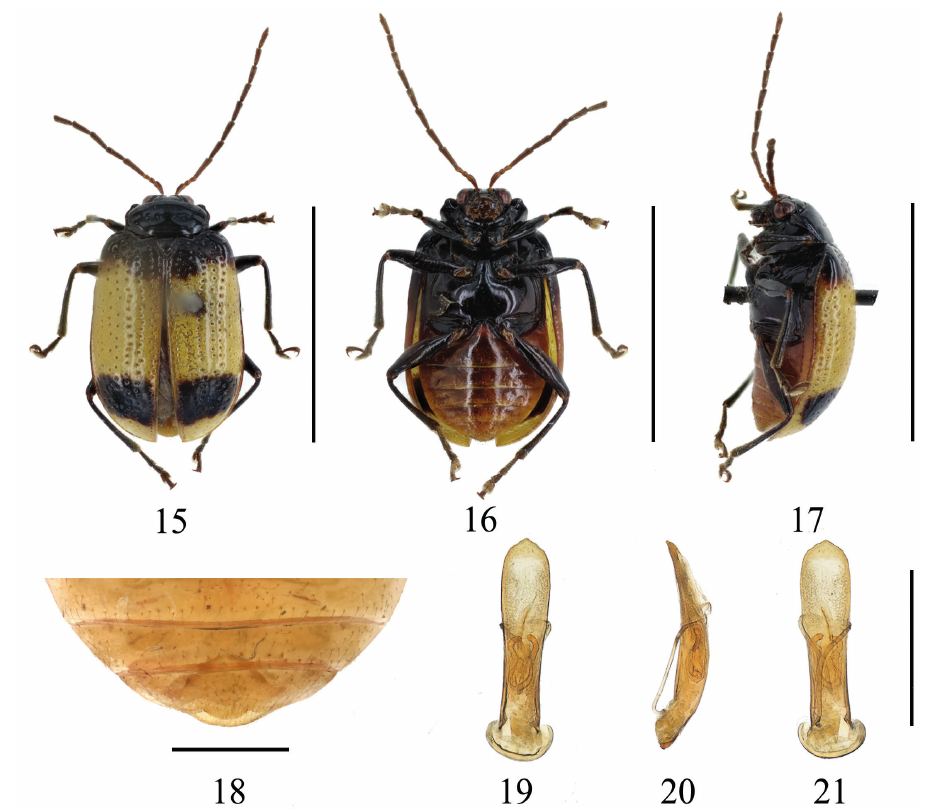
Figures 15–21. Gallerucida nigrovittata sp. nov. 15 dorsal view (holotype) 16 ventral view